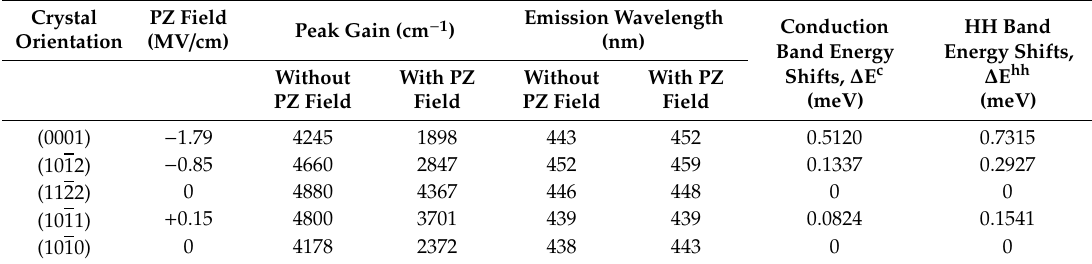
Table 5. E ff ect of PZ field in di ff erent crystal